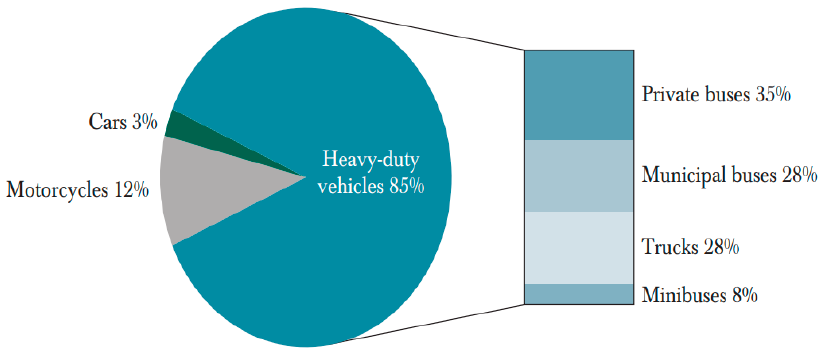
Figure 2. Mobile sources of pollution [14].